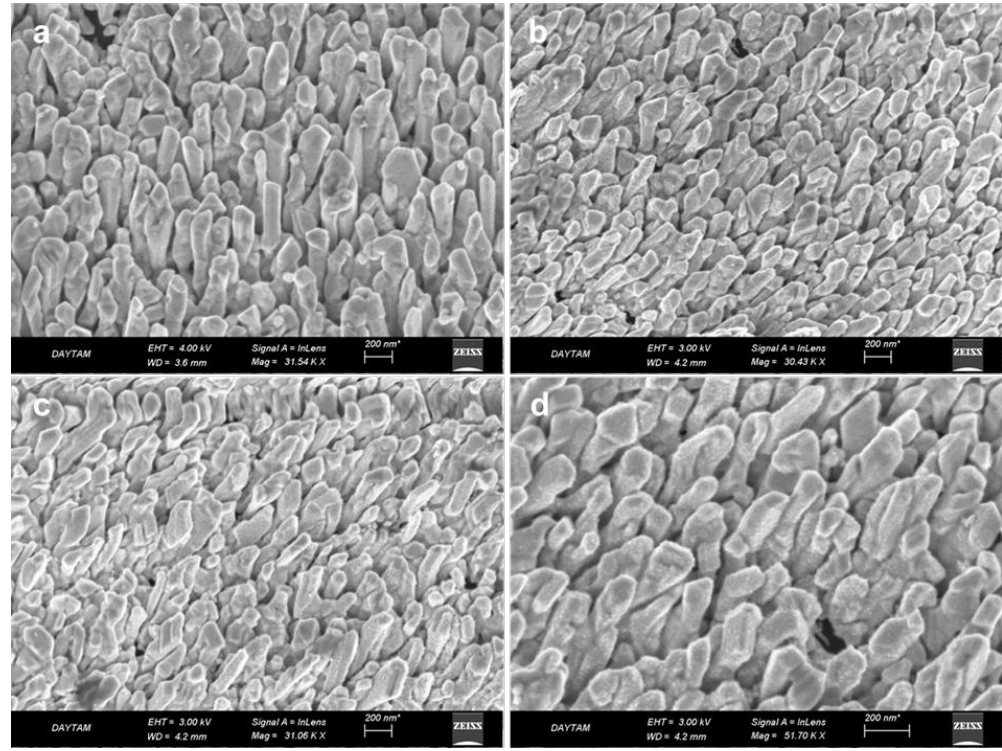
Figure 4. Representative SEM images of GNA@PDOP@AgNP for different PDOP deposition times: ( a ) 10 min, ( b ) 30 min, ( c ) 60 min, and ( d ) 180 min.